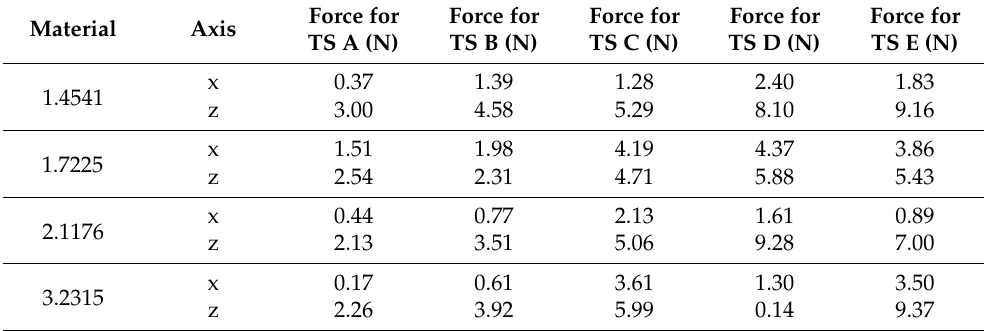
Table 7. Ratio of x- and z-axes forces (TNR) in relation to selected materials and traverse speeds. TNR Using TNR Using TNR Using TNR Using TNR Material TS A TS B TS C TS D